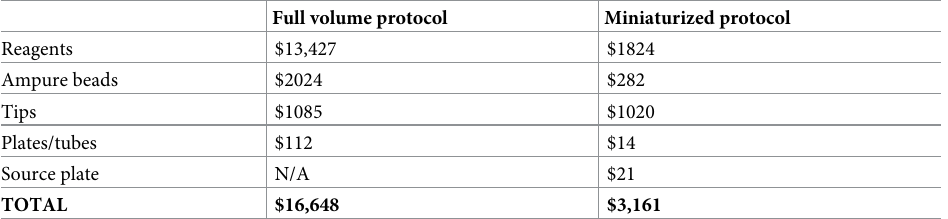
Table 2. Cost comparison of full-volume and miniaturized protocols for 384